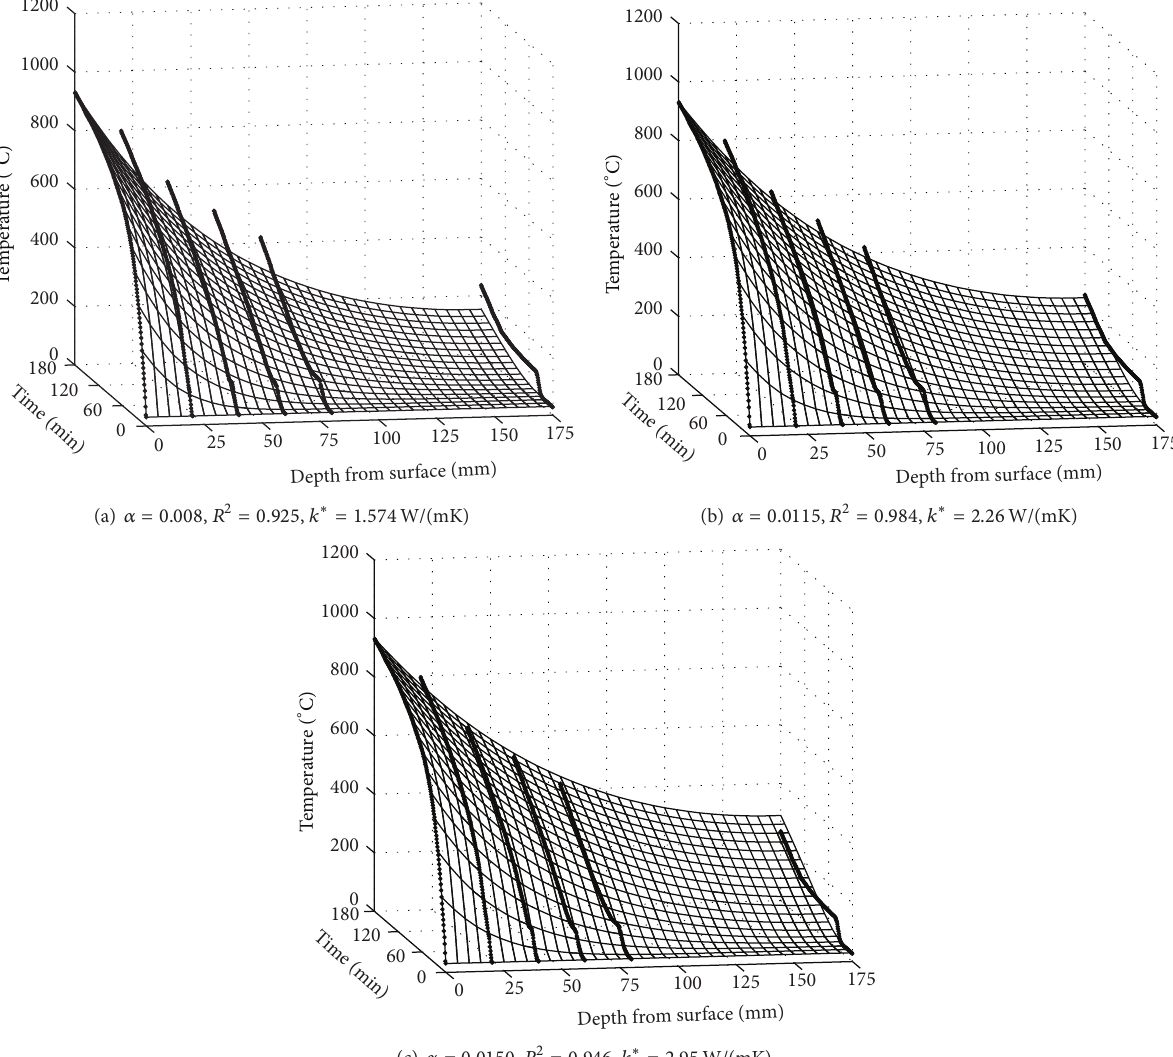
Figure 9: Temperature surfaces according to (a) 𝛼 = 0.008 , (b) 𝛼 = 0.0115 , the optimal surface with the thermal conductivity 𝑘 2.26 W/(mK) which give the maximum 𝑅 2 value of 0.983, and (c) 𝛼 = 0.0150 .